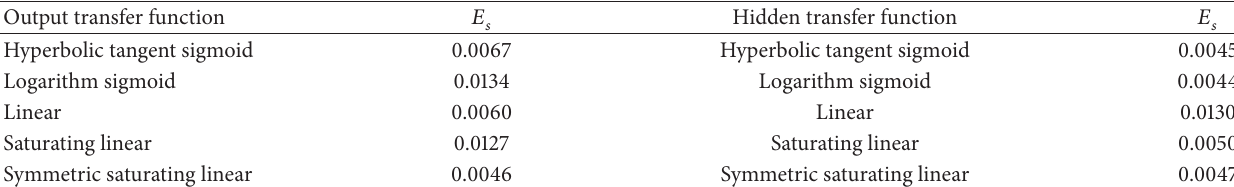
Table 3: Network validation performance with different transfer functions.